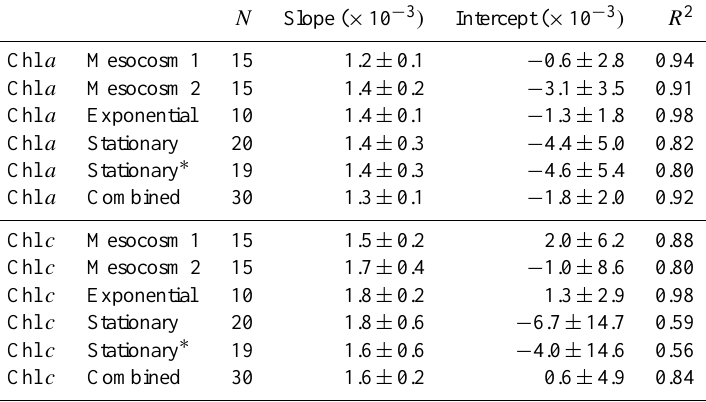
Table 3. Linear regression equations of Phaeocystis absorption on HPLC-measured chlorophyll a and c concentrations. Absorption was cal- culated with the ARP-4 λ -Chl a and ARP-4 λ -Chl c algorithms (Eq. 1). Regressions were made for the mesocosms separately, for exponential (day 0–4) and stationary (day 5–14) growth phases. Indicated are slope and intercepts ± 95% confidence